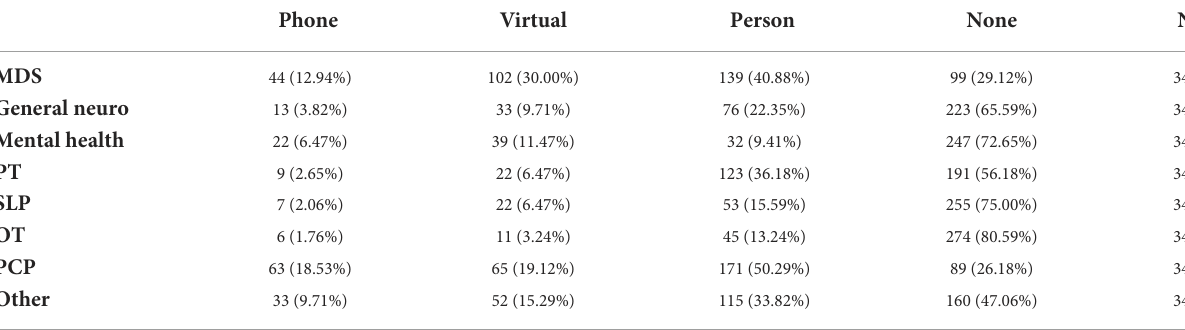
TABLE 3 Veteran self-reported utilization of healthcare service in the previous 12